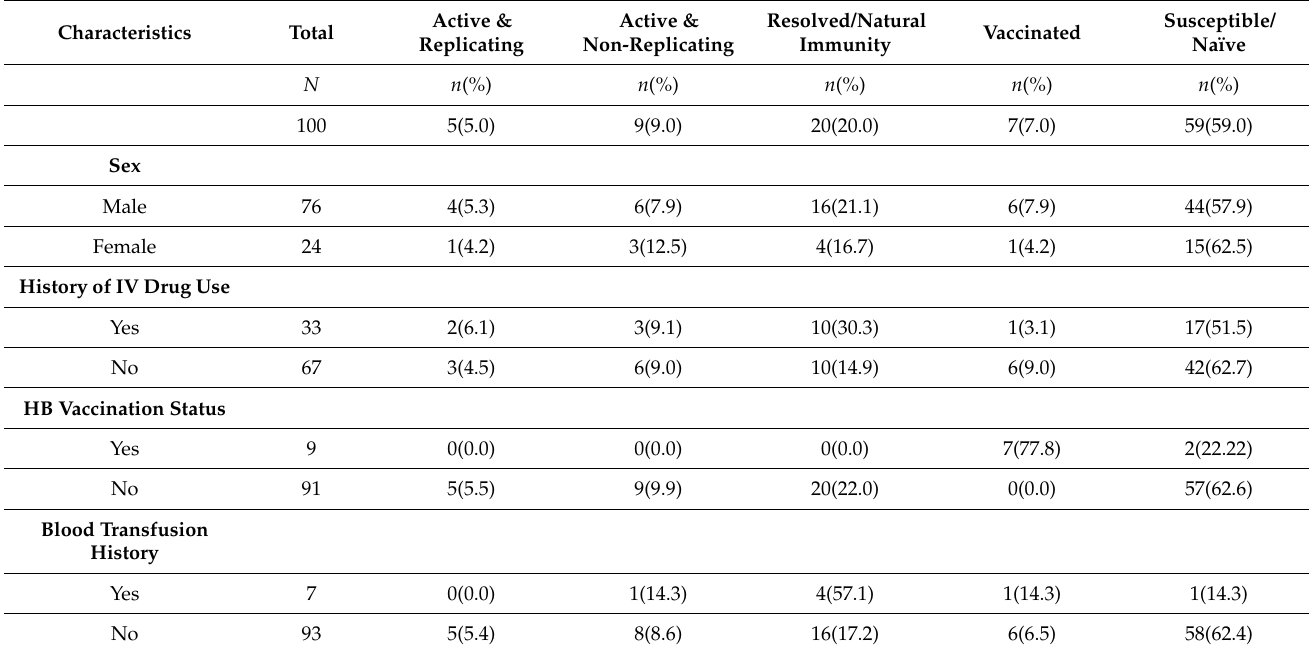
Table 2. Seroprevalence of the different HBV infection